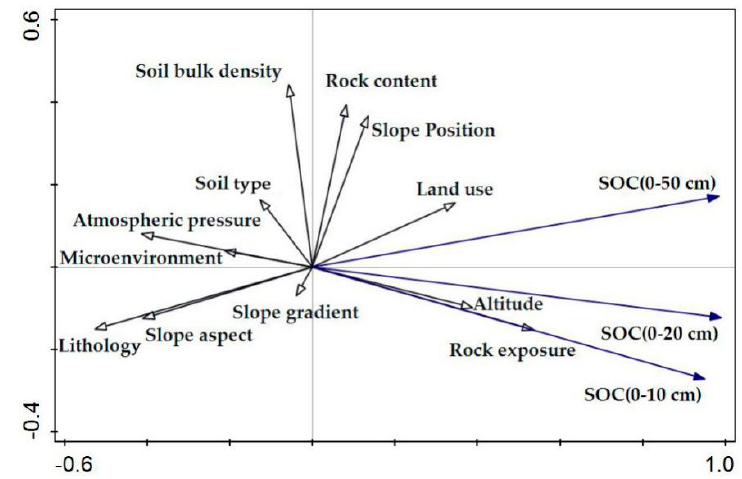
Figure 8. The sorting of correlation between topsoil soil organic carbon (SOC) and different factors.